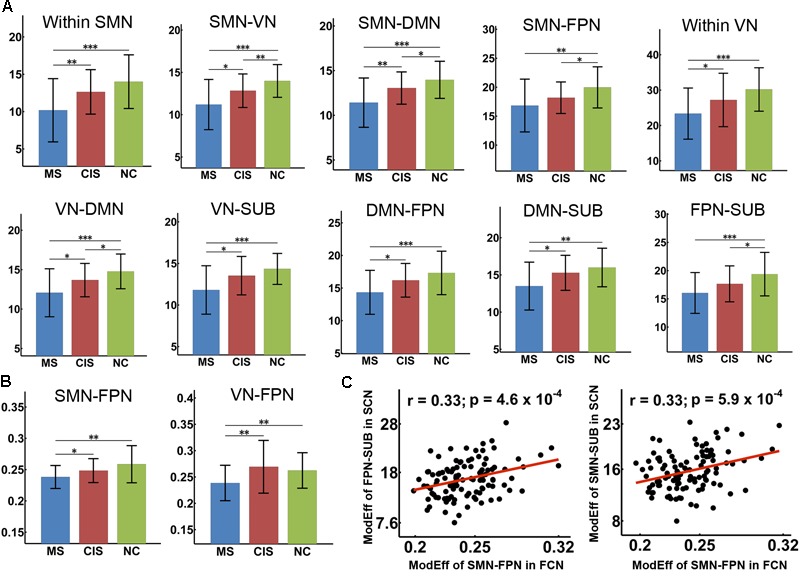
Decreased module efficiency of the SC and FC networks in CIS and MS patients. The bar and error bar represent the mean values and standard deviations of the module efficiency in each group. (A) Significantly reduced module efficiency of the SC networks was observed in both CIS and MS patients relative to the controls (all p < 0.05, corrected). (B) Significantly decreased inter-module efficiency was found in the FC networks in MS patients relative to controls and CIS patients. ∗p < 0.05; ∗∗p < 0.01; ∗∗∗p < 0.005. (C) Significant correlations were identified between the decreased module efficiency of the SC network and FC network across all patients (p < 0.001). ModEff, module efficiency; FCN, functional connectivity network; SCN, structural connectivity network.